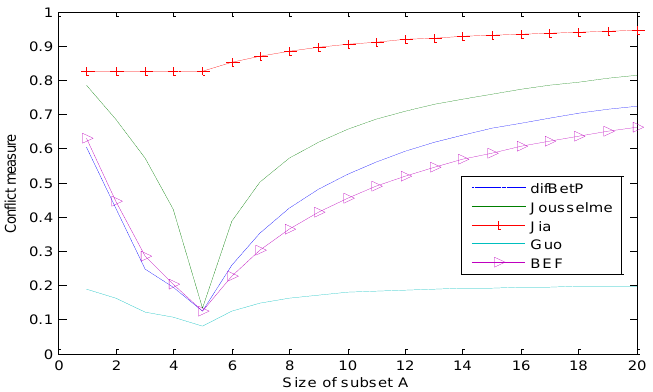
Figure 1. Comparison of different methods when subset A